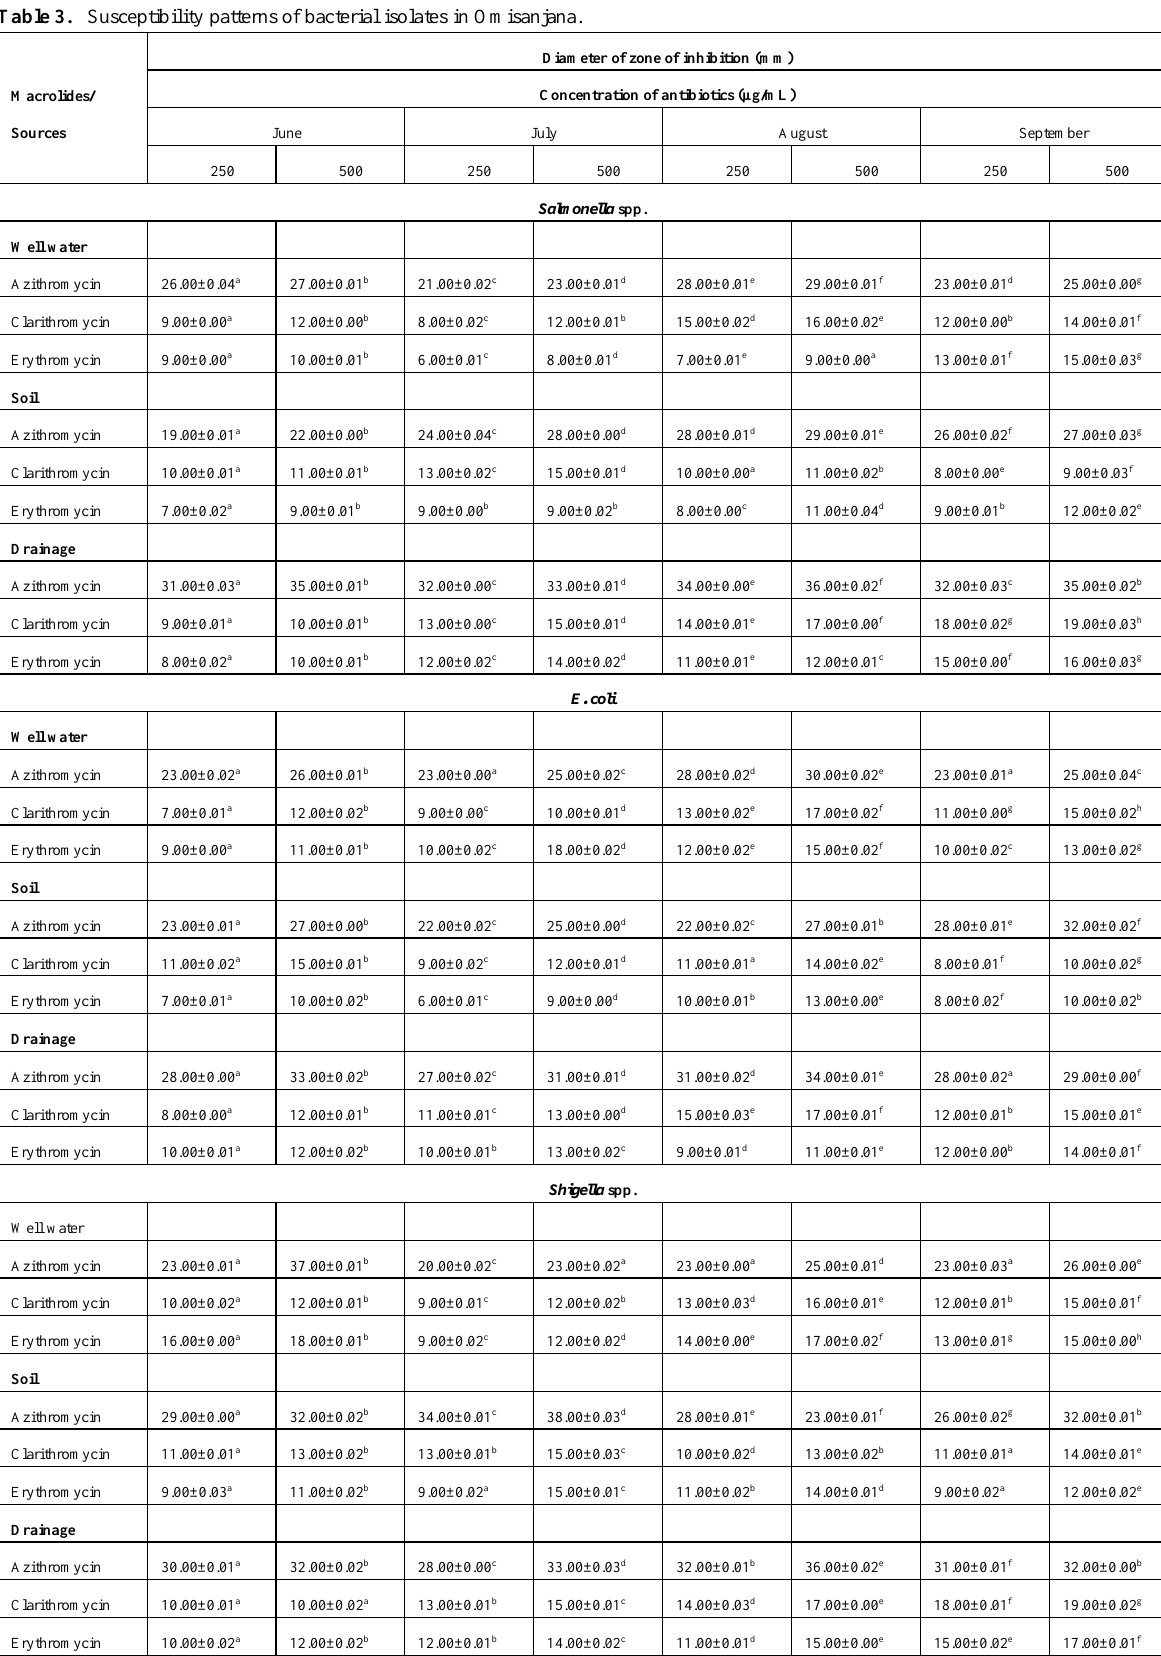
Table 3. Susceptibility patterns of bacterial isolates in